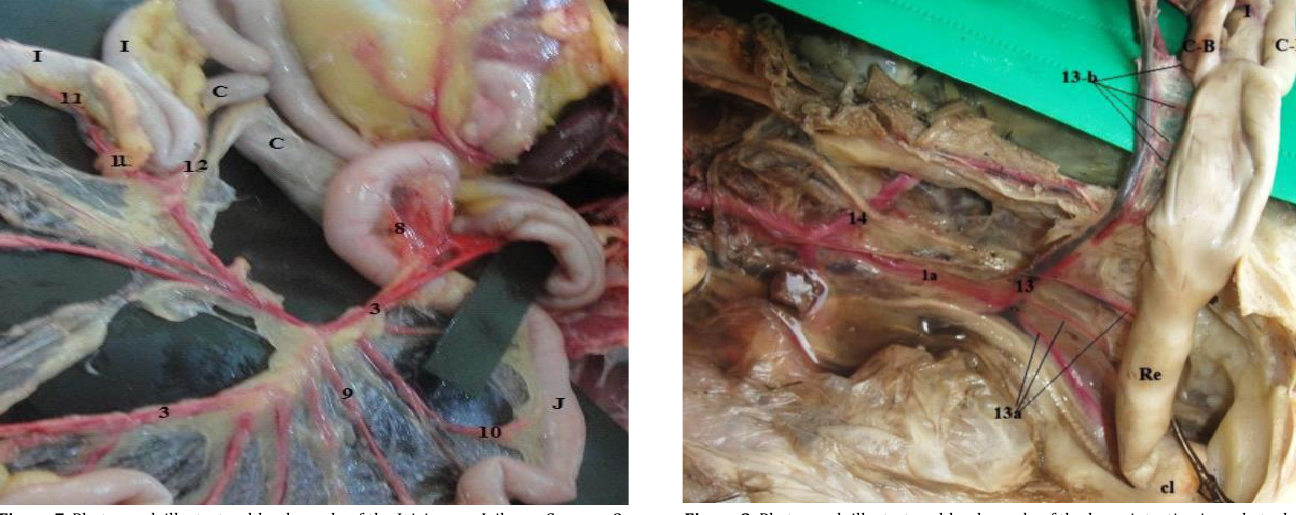
Figure 7 . Photograph illustrates blood supply of the J: jejunum ,I: ileum ,C: cecae ,3: cranial mesenteric a , 8,9: jejunal artery,10 :marginal intestinal artery, 11:ilealartery